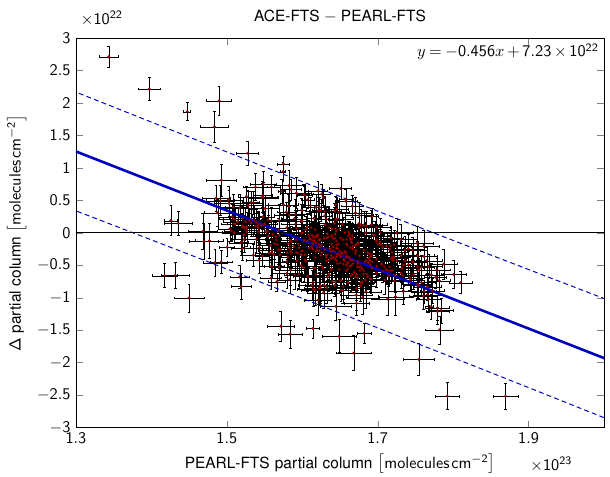
Figure 18. As in Fig. 16, but showing TANSO-FTS – ACE-FTS in a range of